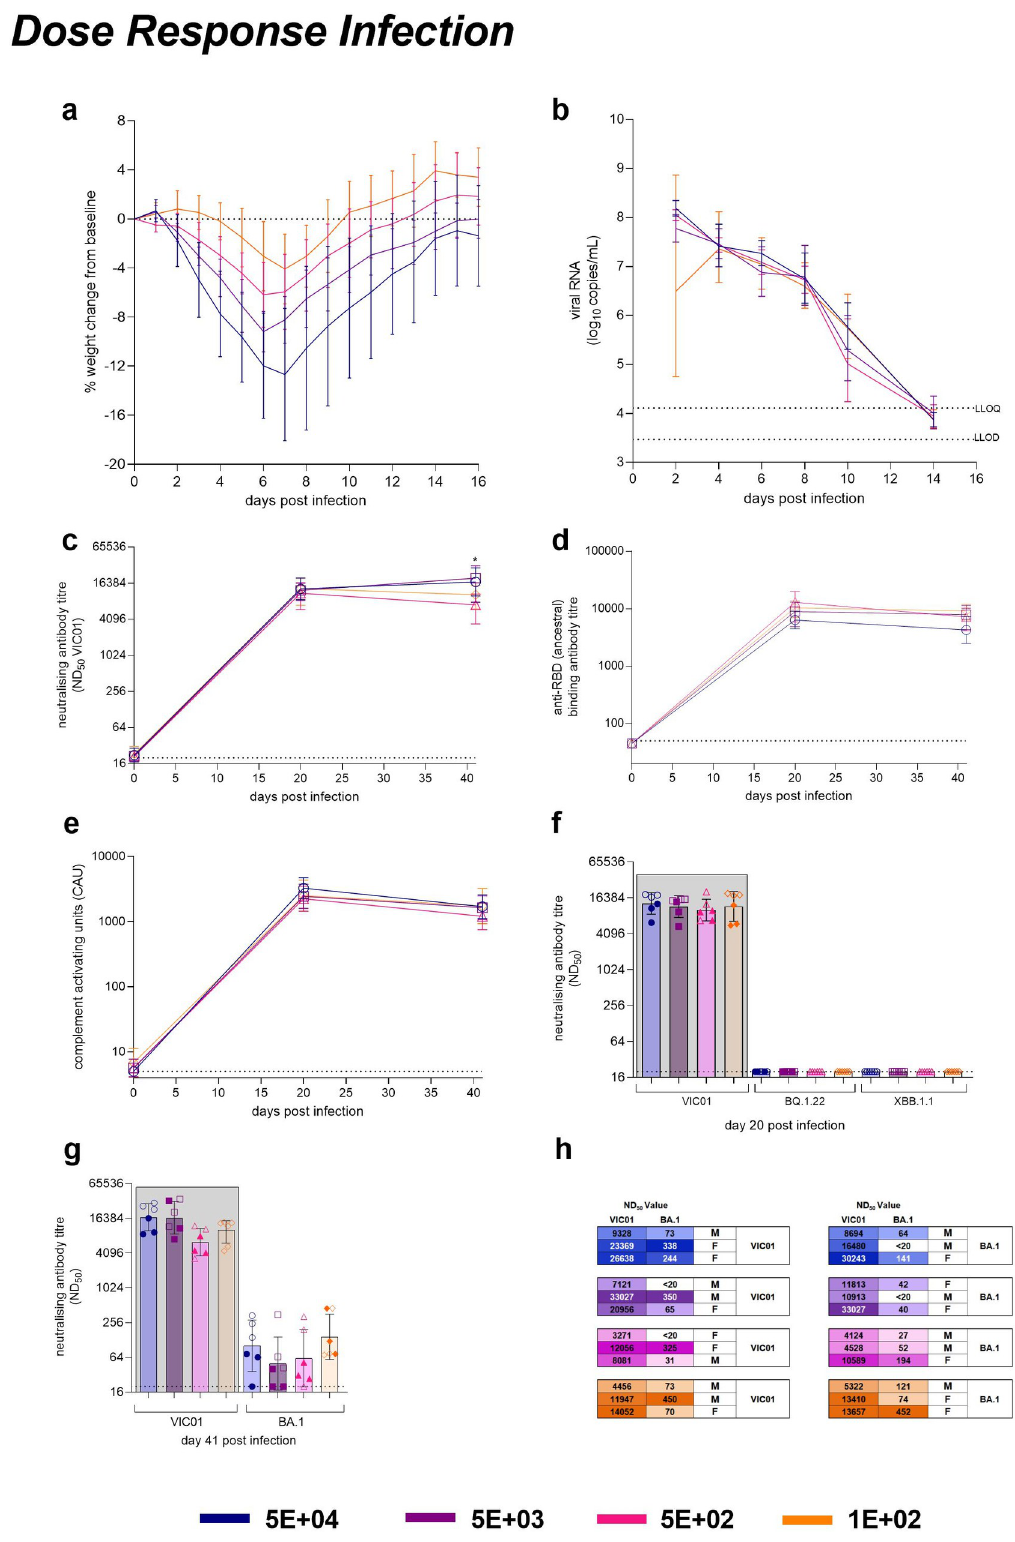
Fig 2. Initial Dose Response with ancestral VIC01. Hamsters were monitored for ( a ) percentage weight change (lines show group means, error bars show standard deviation) relative to baseline (day 0) post-infection. Hamsters challenged with